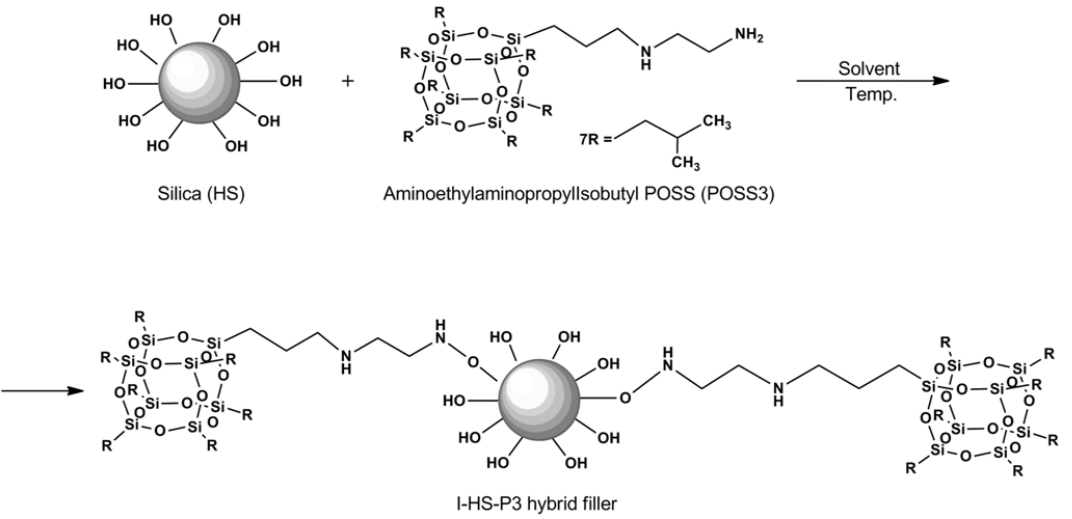
Figure 6. Predicted mechanism of silica surface functionalization.